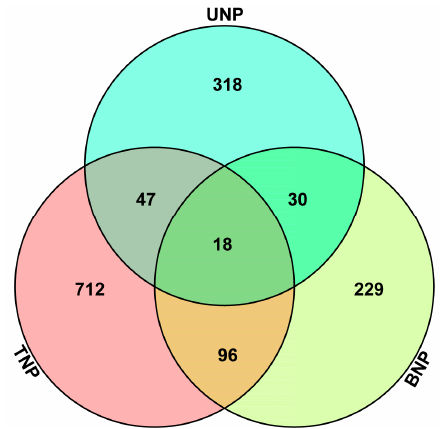
Figure 3. Venn diagrams and expression levels of 1450 differentially abundant proteins (DAPs) identified by iTRAQ in wheat anthers during different development stages. The numbers of DAPs are shown for different developmental stages. UNP, BNP and TNP represent the numbers of DAPs in KTM3315A and TM3315B during the uninucleate stage, binucleate stage and trinucleate stage, respectively.